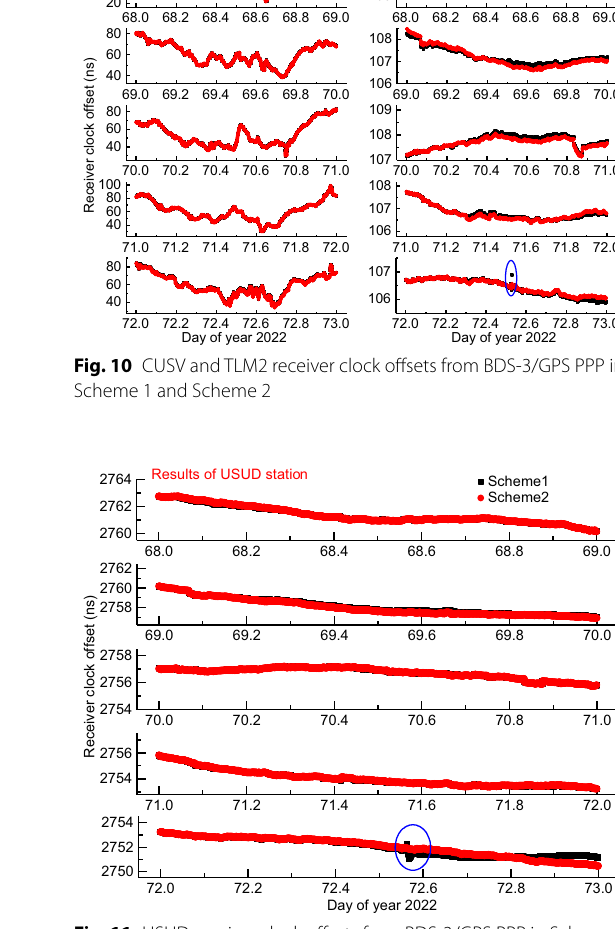
Fig. 9 USUD receiver clock offsets from BDS-3 PPP in Scheme 1 and Scheme 2